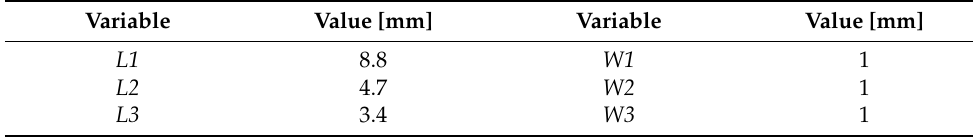
Table 4. The values of the physical dimensions of the E-CRLH